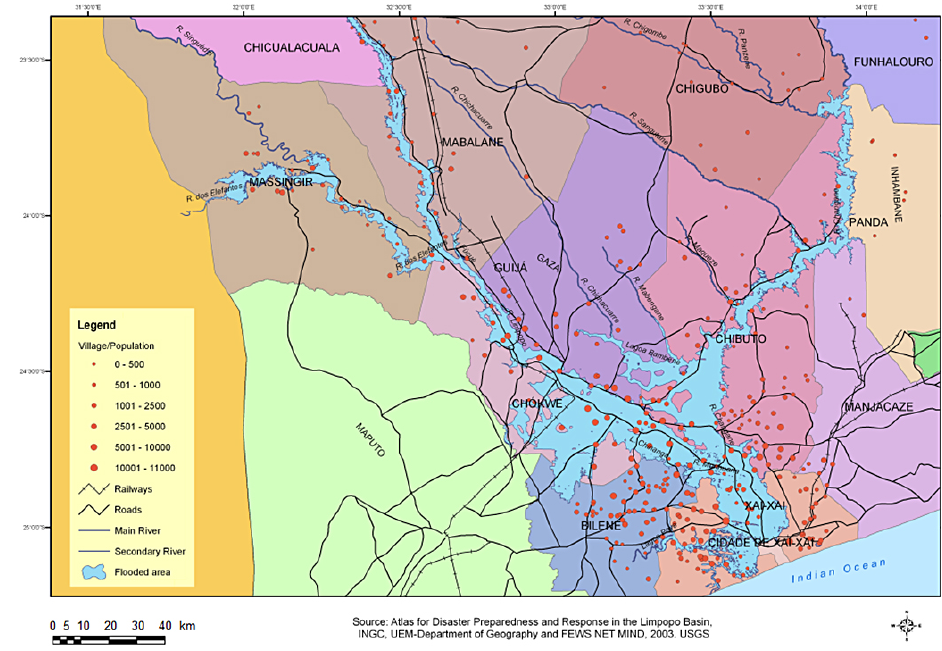
Figure 3. Maximum extent of the 2000 floods in Mozambique (source: INGC et al.,